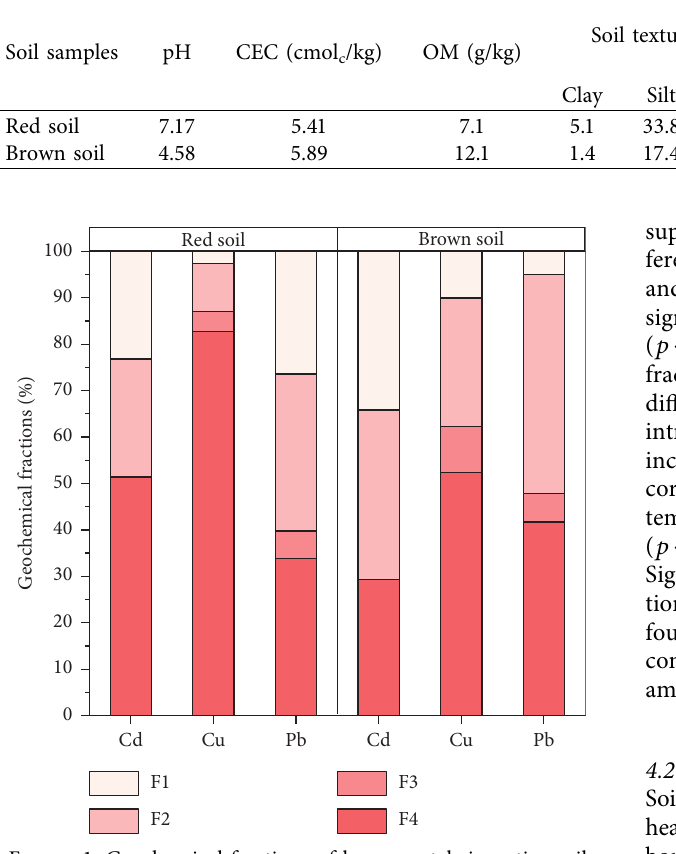
Figure 1: Geochemical fractions of heavy metals in native